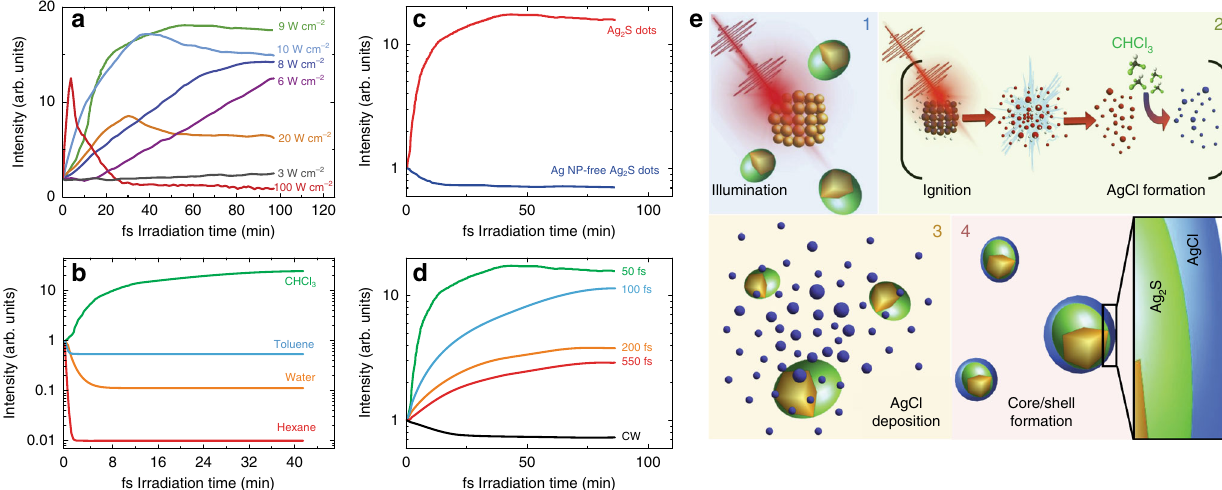
Fig. 3 Required conditions and mechanisms of laser-induced dot-to-superdot transformation. a Time evolution of the NIR-II fl uorescence generated by colloidal dispersions of Ag 2 S dots in CHCl 3 under irradiation at different power densities. In all cases, pulse width and repetition rate were set to 50 fs and 1 kHz, respectively. b Time evolution of the NIR-II fl uorescence generated by Ag 2 S dots dispersed in different solvents under laser irradiation with 50 fs, 808 nm laser pulses. c Time evolution of the NIR-II fl uorescence generated by Ag 2 S dots under laser irradiation with 50 fs, 808 nm laser pulses in presence and absence of Ag NPs. d Time evolution of the NIR-II fl uorescence intensity generated by Ag 2 S dots in CHCl 3 as obtained for different pulse durations. For all cases in b , c , and d , the ultrafast laser power density was set to 9 W cm − 2 . Different samples were used in each condition used in a , b , c and d . e Schematic representation of the physicochemical mechanisms underlying the ultrafast laser-induced dot-to-superdot transformation. Upon illumination with ultrafast infrared laser pulses, multiphoton excitation of Ag NPs leads to their Coulomb explosion (step 1). The Ag + z generated in this process react with CHCl 3 molecules forming AgCl (step 2), which in turn reacts with the surface of the Ag 2 S dots forming a protective layer (steps 3 and